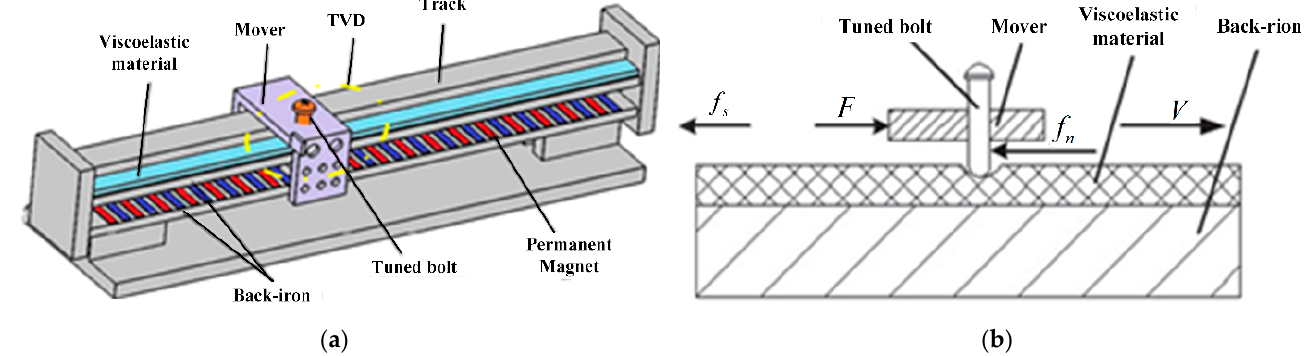
Figure 21. ( a ) System of PMLSM with tuned viscoelastic damper (TVD); ( b ) cross-sectional view of PMLSM with TVD. Reprinted with permission from ref. [107]. Copyright 2018 IEEE.